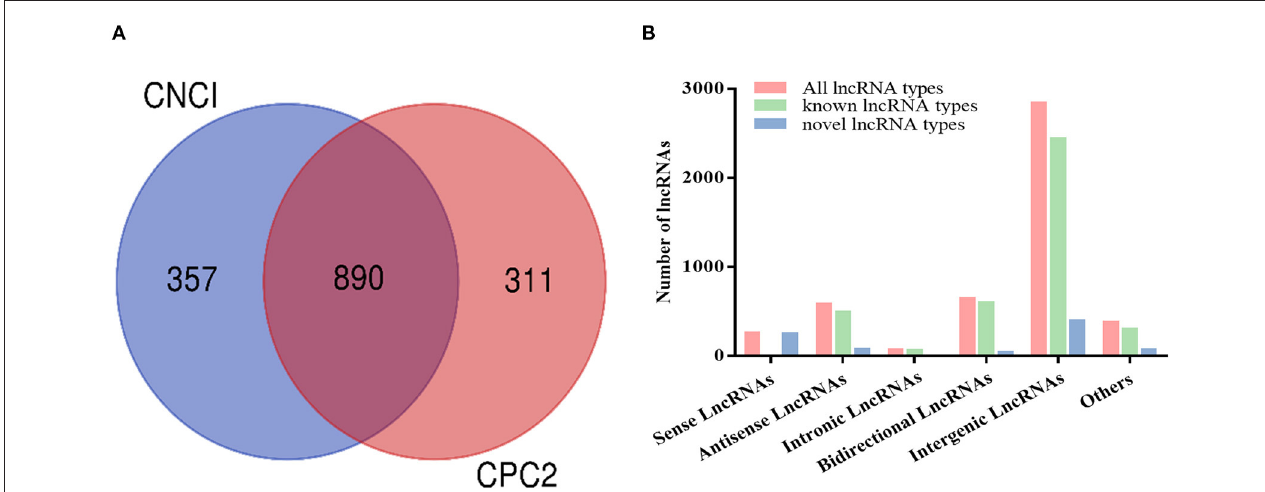
FIGURE 2 | (A) Identification of 890 novel long noncoding RNAs (lncRNAs) without protein-coding potential evaluated by CNCI and CPC2. (B) LncRNA type distribution.